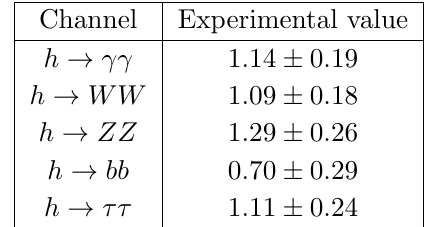
Table 7 . List of the Higgs signal strengths used in this analysis